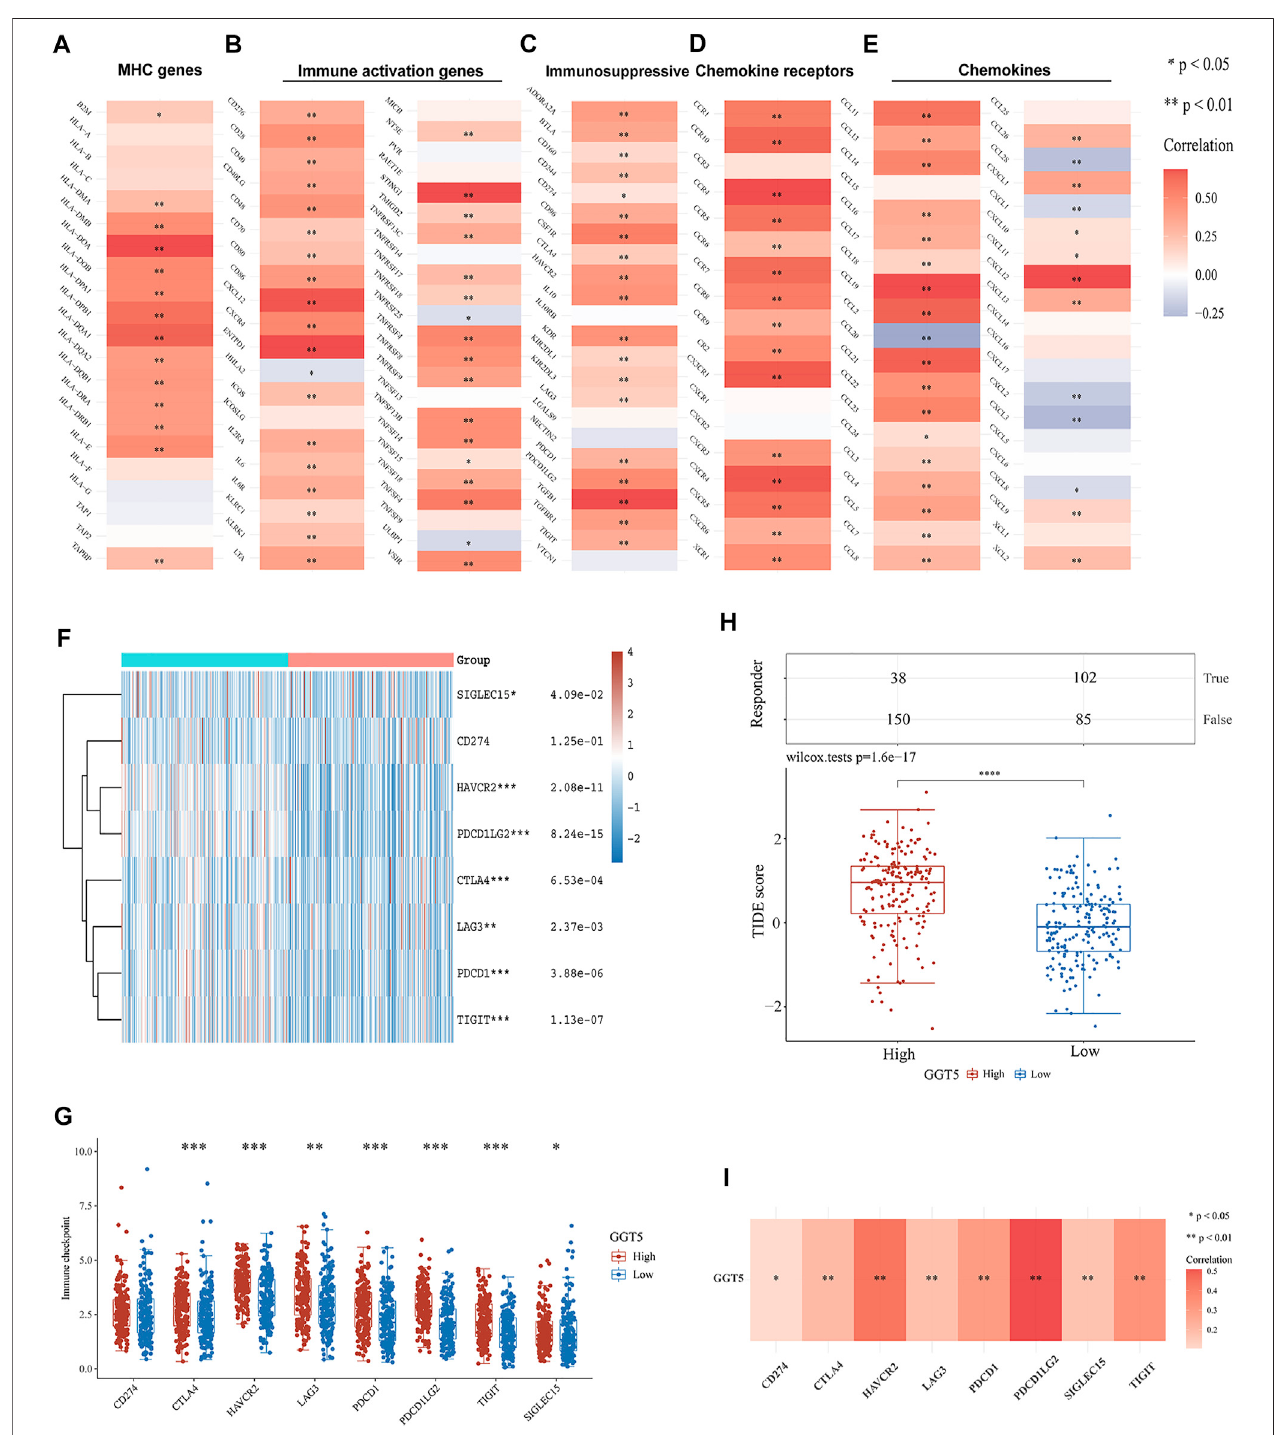
FIGURE 6 | Correlation of GGT5 with immune-related genes and immune checkpoint genes in gastric cancer. Correlation of GGT5 and MHC genes (A) , immune activation genes (B) , immunosuppressive genes (C) , chemokine receptors (D) , and chemokines (E) . (F,G) The expression patterns and levels of immune checkpoint genesin different GGT5 expression groups. (H) The predicted responsetoimmunecheckpoint blockade therapy in different GGT5 expression groups. (I) Correlationof GGT5 with immune checkpoint-related genes. *, p < 0.05; **, p < 0.01; ***, p < 0.001; ****, p < 0.0001.